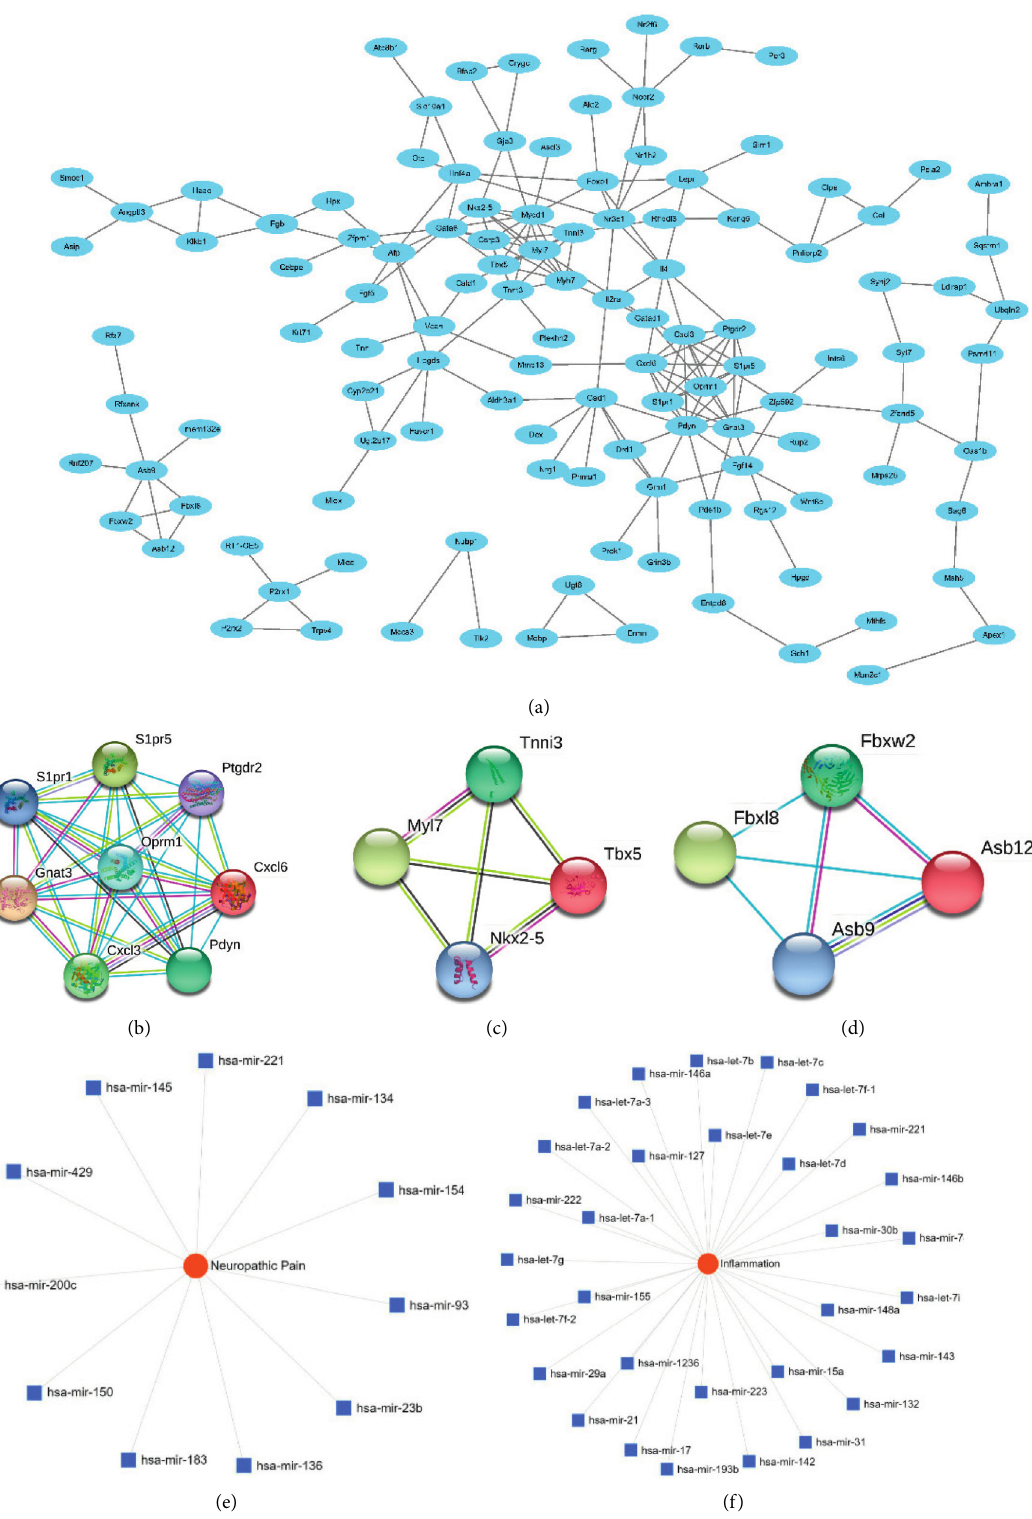
Figure 4: Protein-protein interaction (PPI) network and MCODE genes. (a) Protein-protein interaction network of DEGs. (b–d) Significant modules. (e) Neuropathic pain-related miRNAs. (f) Inflammation-related